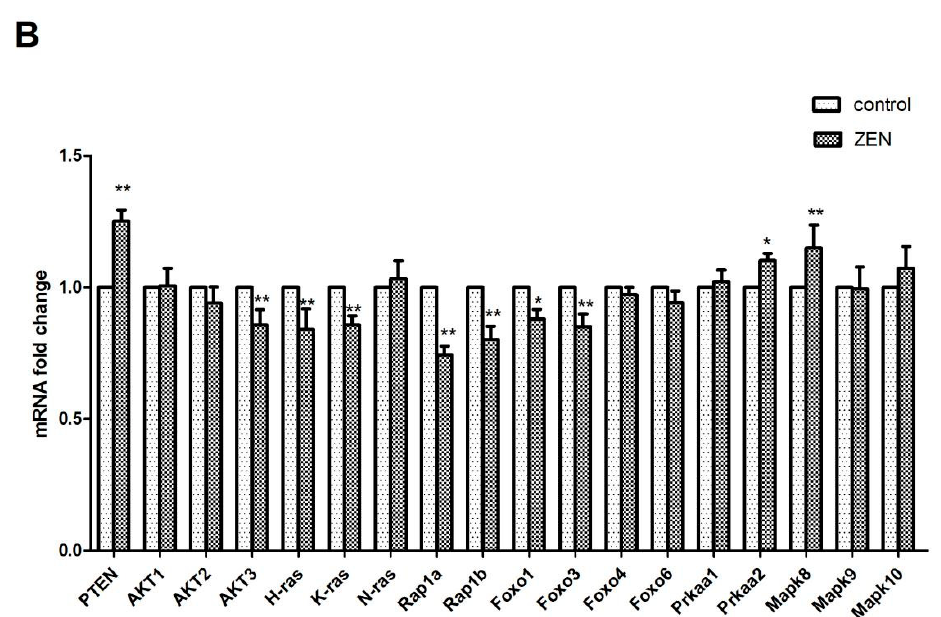
Figure 5. ( A ) Validation of the differentially expressed miRNAs. ( B ) Verification of the miRNA target genes. The qRT-PCR analyses of the mRNA expression levels ofmiR-146b-3p, miR-3098-5p, miR-185-3p, miR-467e-3p, miR-411-5p, miR-301a-5p, miR-210-5p, miR-326-3p, miR-615-5p, miR-410-3p, miR-96-3p, miR-19a-3p, miR-96-5p, miR-221-5p, miR-3057-5p, PTEN, AKT1, AKT2, AKT3, H-ras, N-ras, K-ras, Rap1a, Rap1b, Foxo1, Foxo3, Foxo4, and Foxo6 in the control and ZEA-exposed TM3 Leydig cells. The gene expression levels represent the mRNA expression levels relative to the control levels (the values represent mean ± SD). The asterisks are used to indicate a statistically significant difference: * p < 0.05; ** p < 0.01.